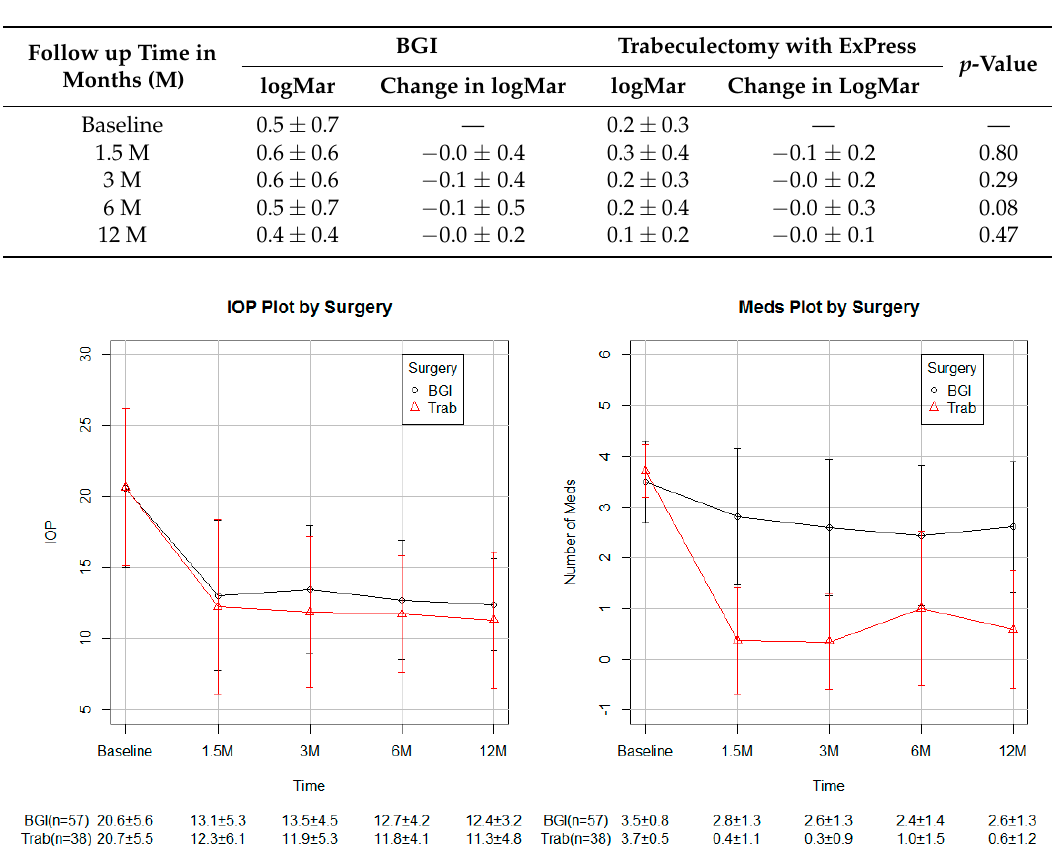
Table 4. Visual acuity (VA) and change in VA.